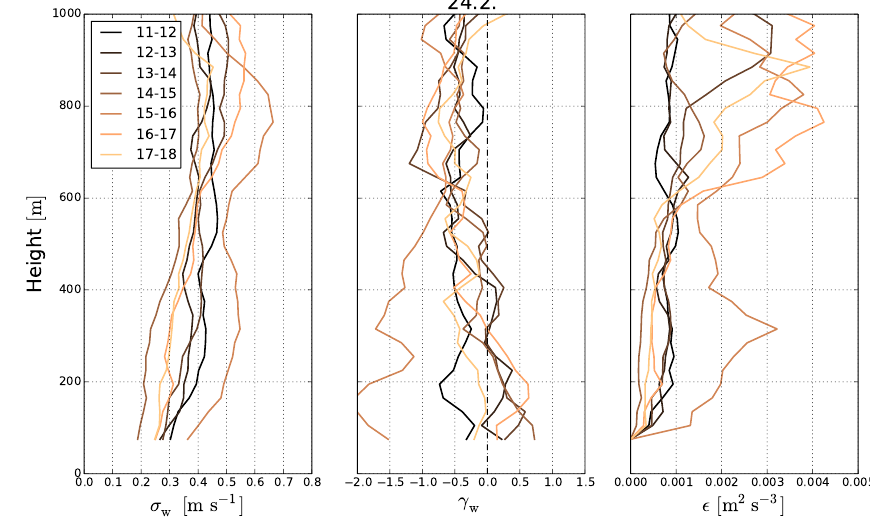
Figure 6. Profiles of the standard deviation ( σ w ) and skewness ( γ w ) of vertical velocity and the dissipation rate ( (cid:15) ) for 1h segments during the early hours of 24